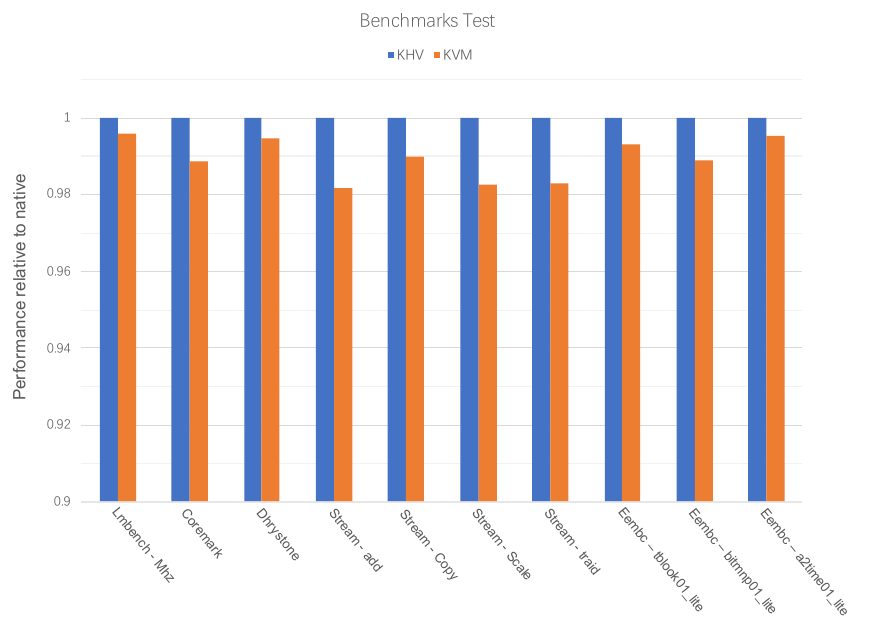
Figure 15. Benchmark test results.